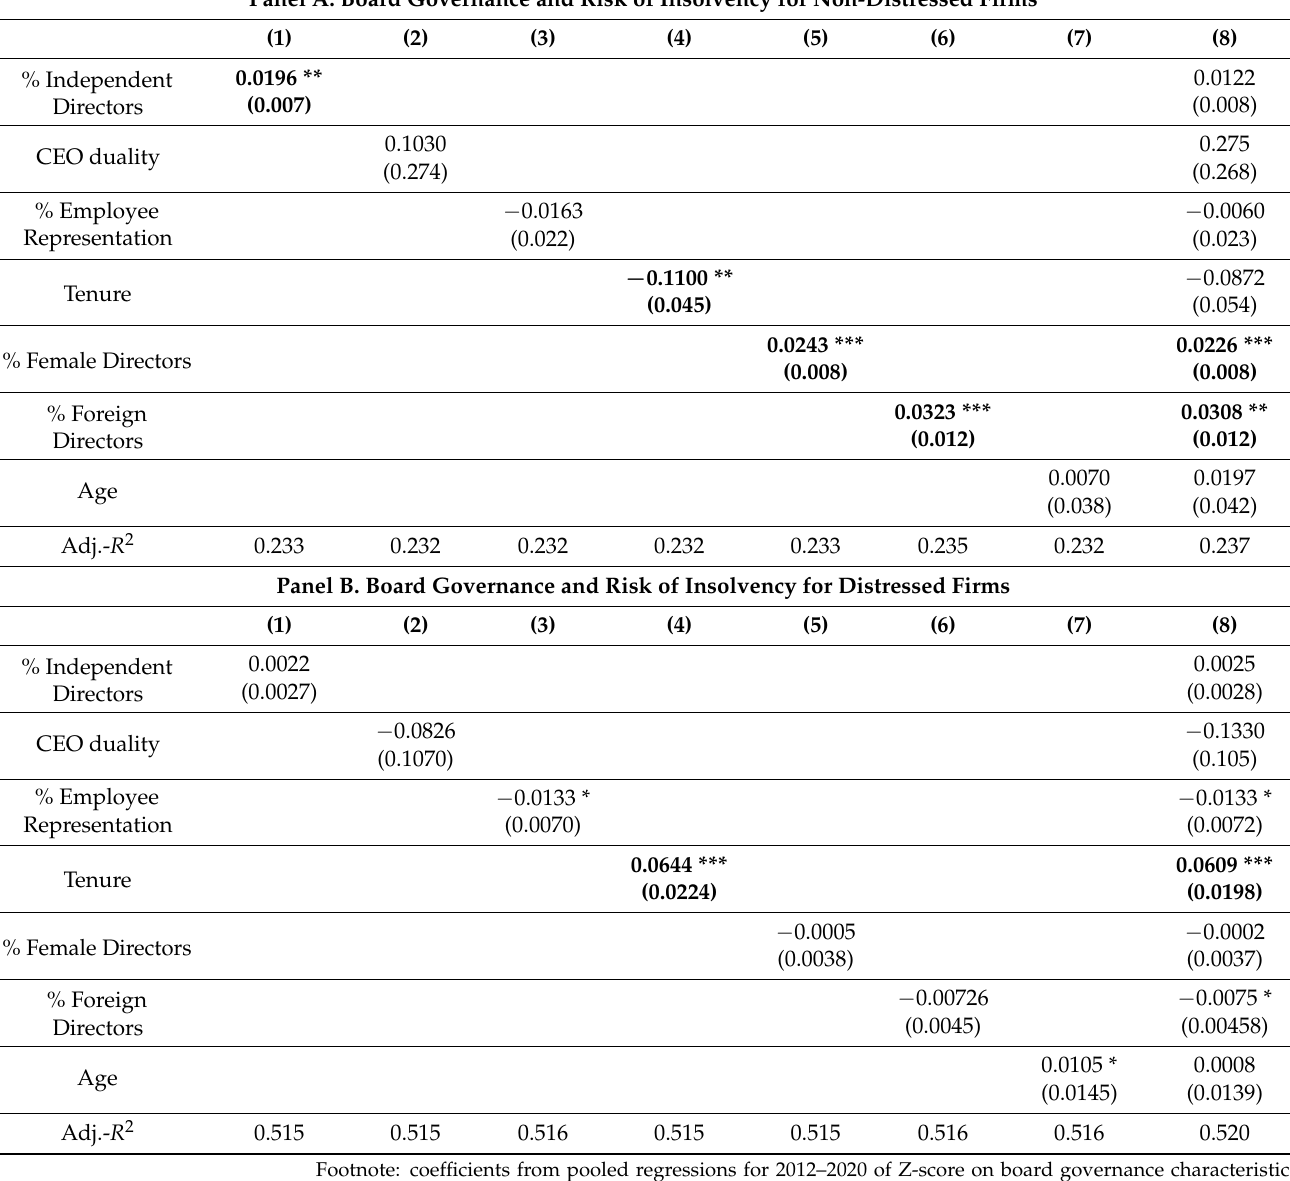
Table 4. Board Governance and Risk of Insolvency for Non-distressed and Distressed Firms. Panel A. Board Governance and Risk of Insolvency for Non-Distressed